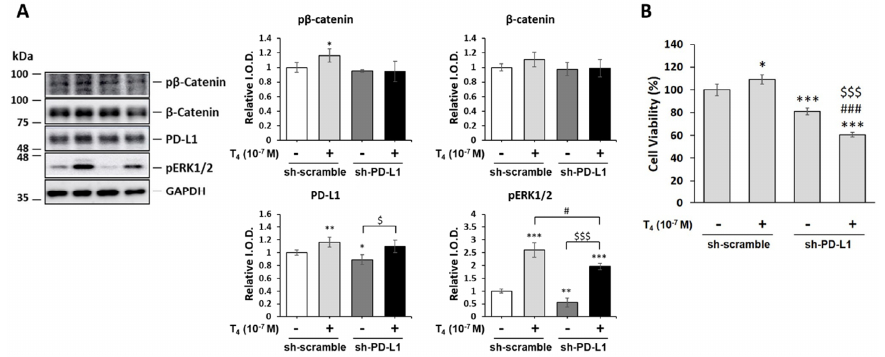
Figure 7. Thyroid hormone (T 4 )-induced PD-L1-dependent protein expression and cell proliferation in oral cancer cells. ( A ). Oral cancer OEC-M1 cells were seeded in six-well trays and were transfected with either PD-L1 shRNA or a scrambled plasmid (0.5 µg/well). Prior to treatment, cells were refed with hormone-stripped FBS-containing medium and treated with T 4 (10 −7 M) for 24 h. Cells were harvested, and Western blot analyses of total β-catenin, pβ-catenin, PD-L1, and pERK1/2 were conducted. Data are presented as the mean ± SD. Results are from three independent studies ( n = 4) ** p < 0.01, compared to the control. I.O.D., intensity of the optical density. ( B ). Oral cancer OEC-M1 cells were seeded in 24-well trays and were transfected with either PD-L1 shRNA or a scrambled plasmid (0.1 µg/well). Prior to treatment, cells were refed with hormone-stripped FBS- containing medium and treated with T 4 (10 −7 M) for 72 h. Cells were harvested for cell viability assay. Data are presented as the mean ± SD. Results are from three independent studies ( n = 6) * p < 0.05, ** p < 0.01, *** p < 0.001, compared to the control; # p < 0.05, ### p < 0.001, compared to T 4 , and $ p < 0.05, $$$ p < 0.001,compared to PD-L1 shRNA group.